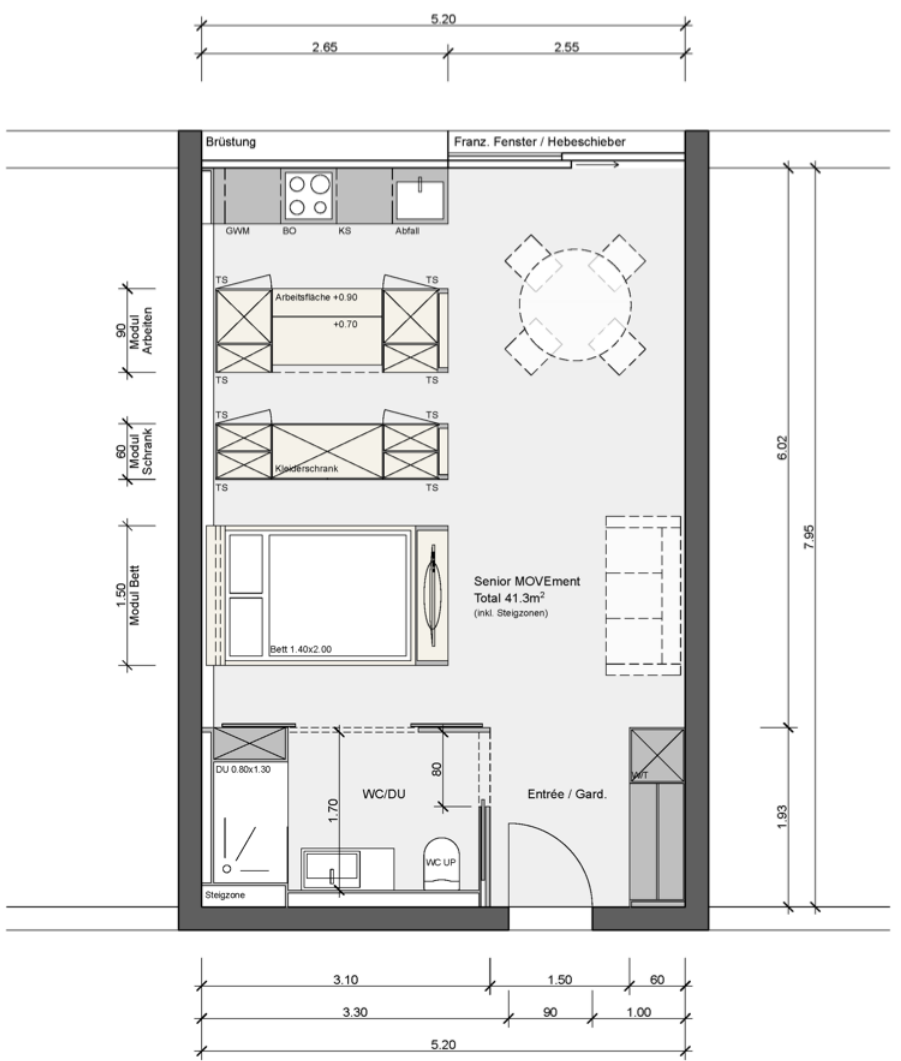
Figure 11. Halter, flexible MOVEment system, plan of the main type. Image courtesy of